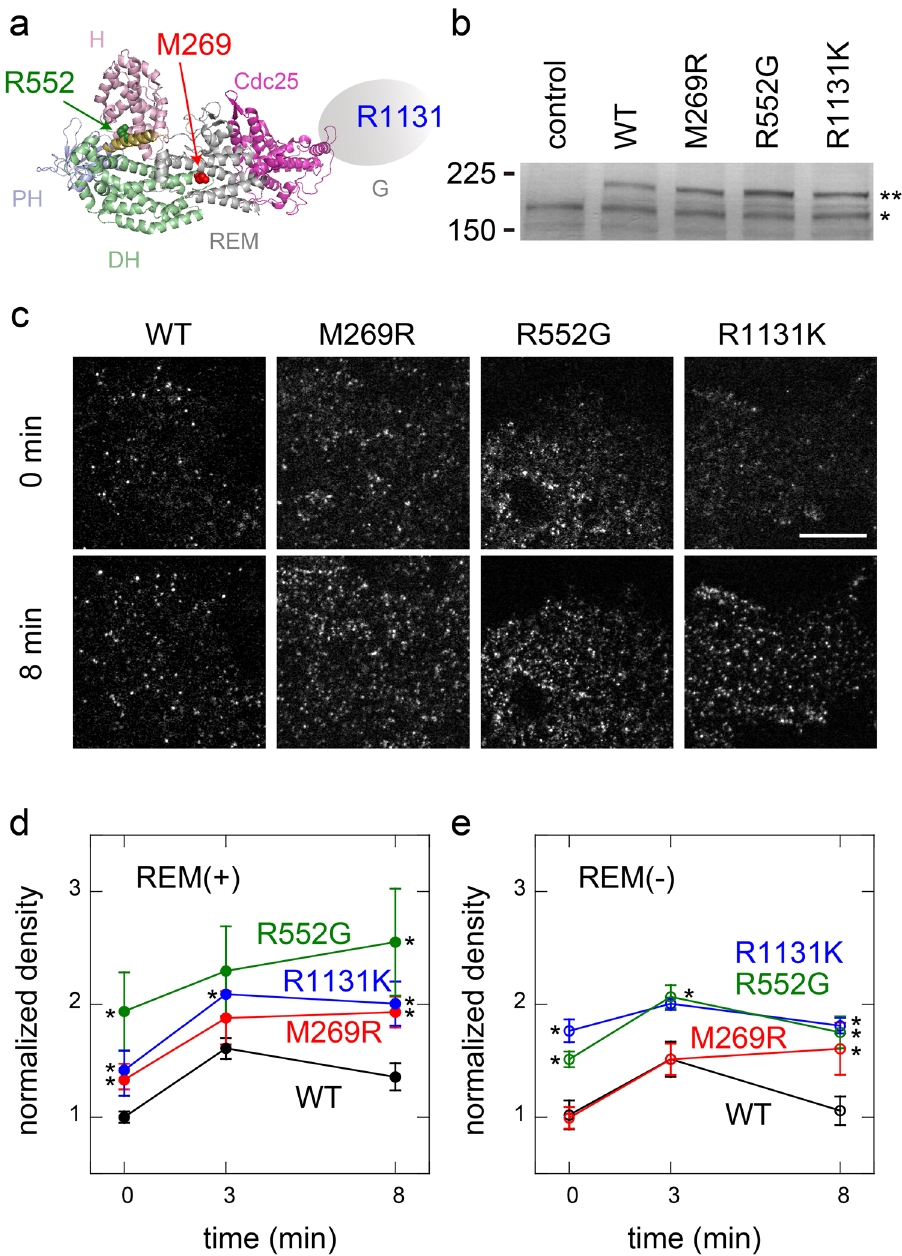
Figure 1. Single-molecule imaging of NS SOS dynamics. ( a ) Locations of NS mutations in SOS (M269, R552, and R1131) in the atomic structure (PDB ID: 3KSY 15 ). Atomic structure of the G domain is unknown. ( b ) Expression of SOS proteins detected by immunoblotting analysis with anti-SOS1 antibody. ( ** Halo-tagged and * endogenous SOS). Full-length blot image is shown in Supplementary Fig. S2. ( c ) Typical micrographs of single SOS molecules on the cell surface before and after EGF stimulation for 8 min. The upper and lower micrographs show the same cells. Bar: 10 μ m. ( d , e ) Translocation of SOS molecules to the cell surface. The molecules contained the REM( − ) mutation ( e ) or did not ( d ). Densities of the fluorescent SOS molecules on the cell surfaces were normalized to the fluorescence intensity in the cytoplasm and plotted as values relative to that of WT SOS before EGF stimulation (time 0). Means of 6–10 cells are plotted with standard errors (SE). Asterisks indicate statistical significance relative to WT ( d ) or WT REM( − ) ( e ) at the indicated times (p < 0.05 on Mann–Whitney